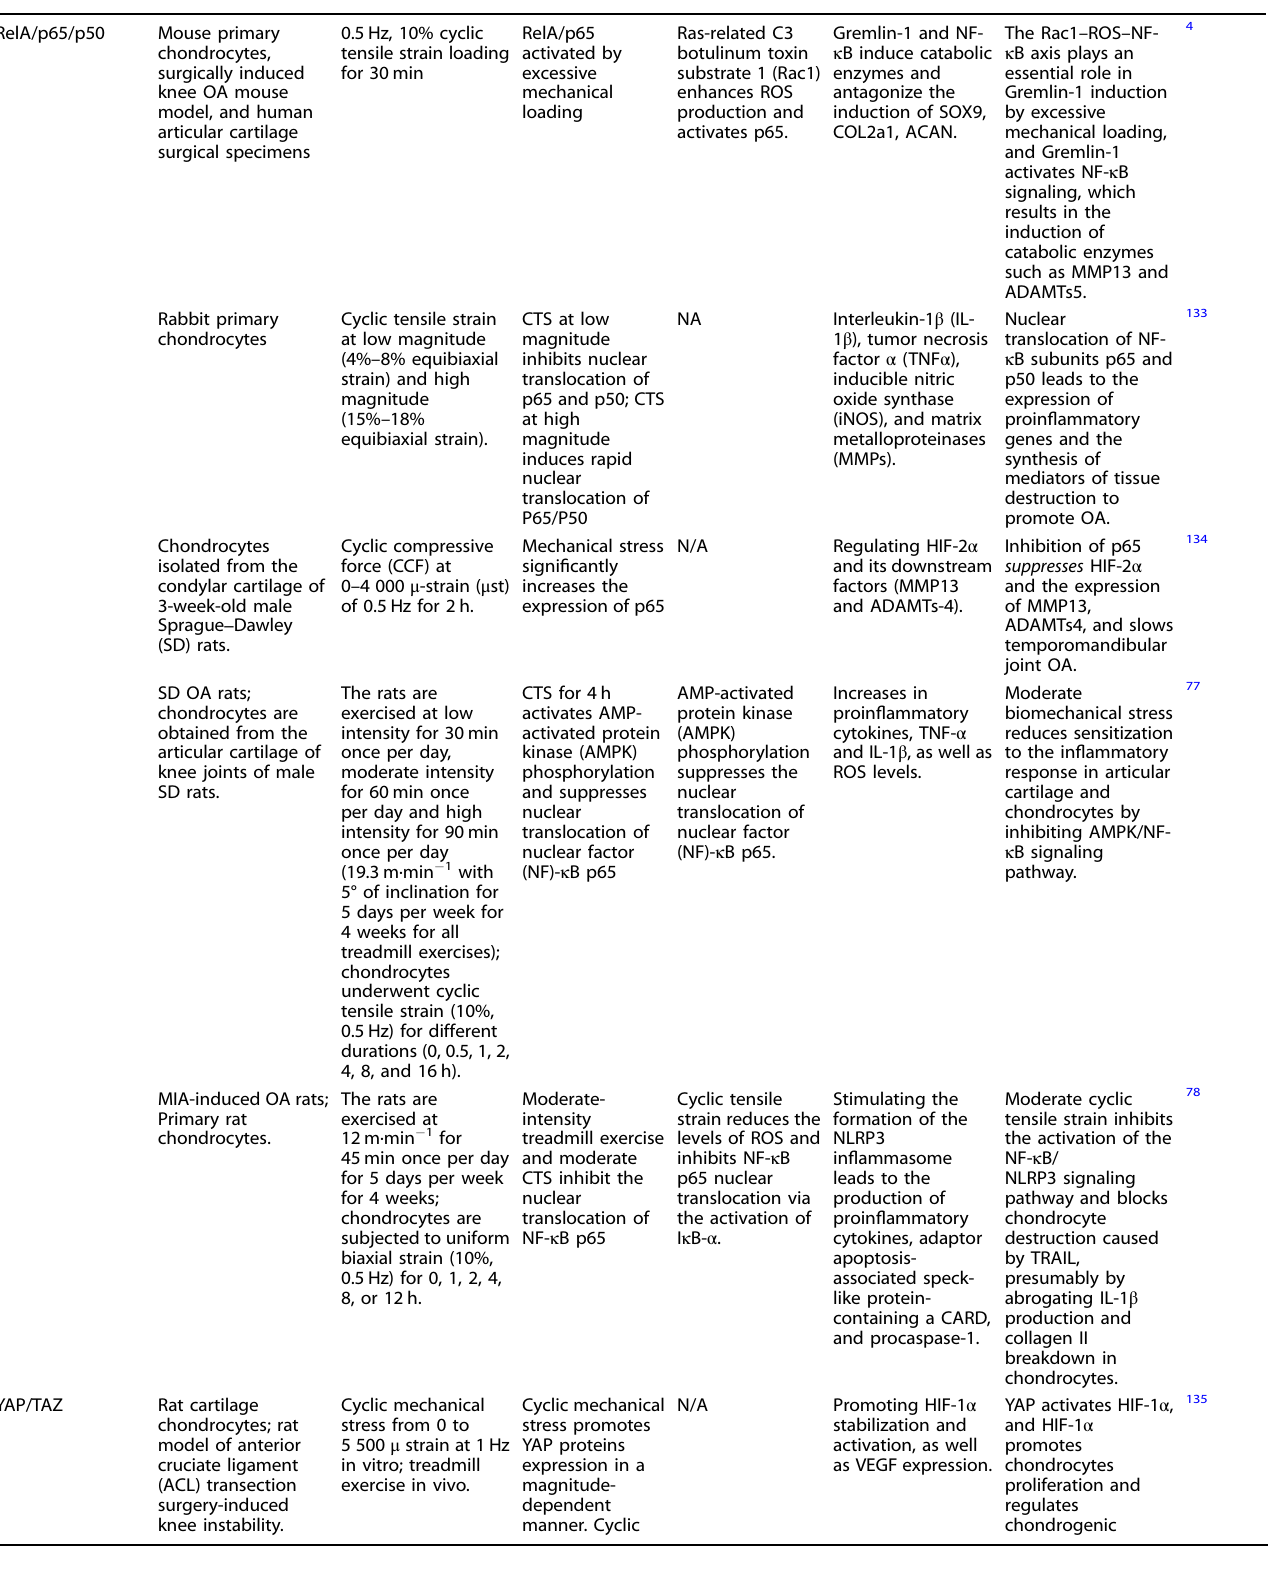
Table 2. Mechanosensitive transcription factors (TFs) in chondrocytes Cell, tissue, or animal Mechanosensitive model TFs in chondrocytes